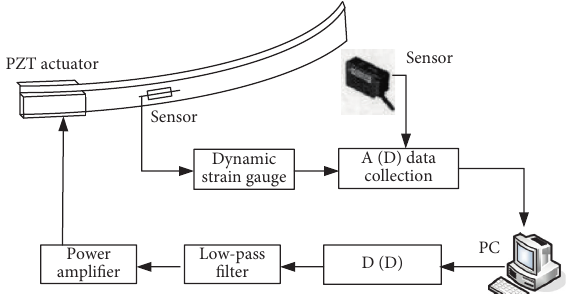
Figure 1: Vibration control principle of the PZT actuator.